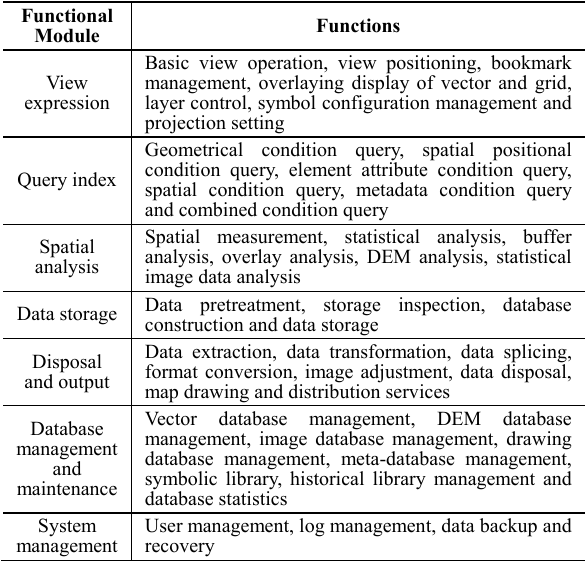
Table 3. Functional Evaluation Range of Management